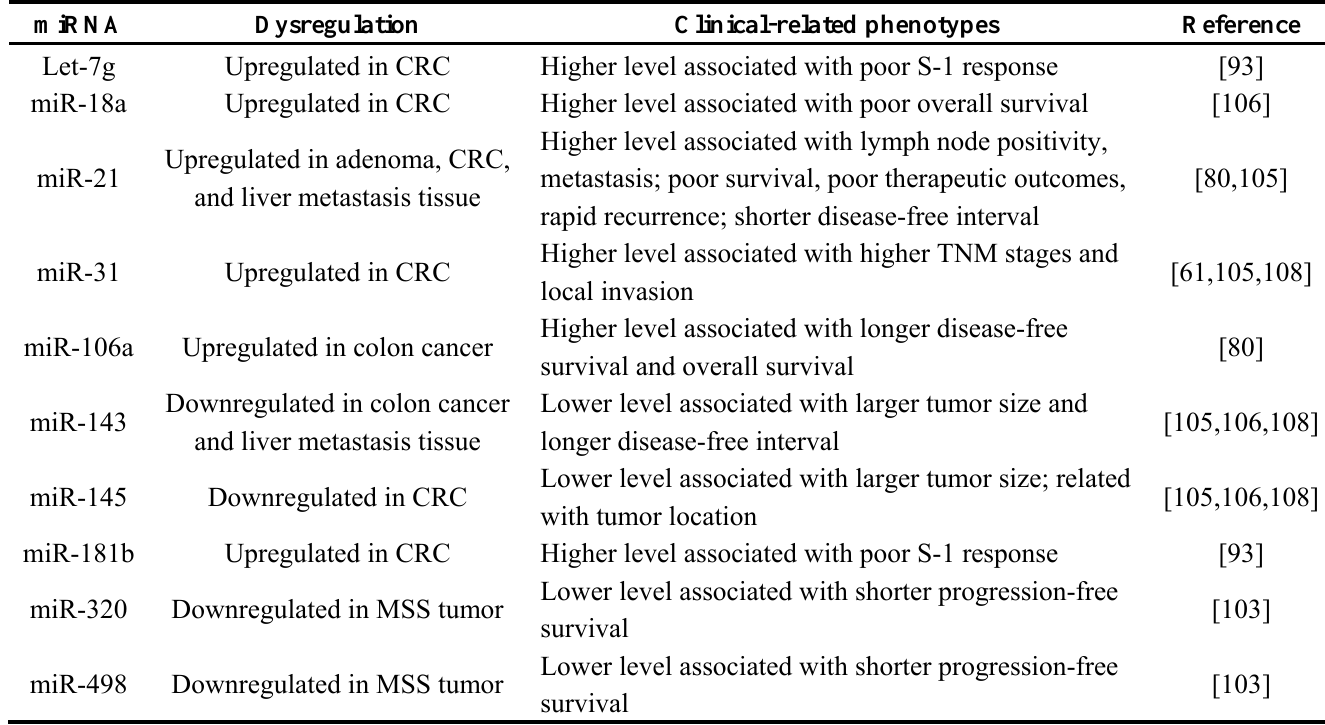
Table 1. Relevant miRNAs found deregulated in CRC expression